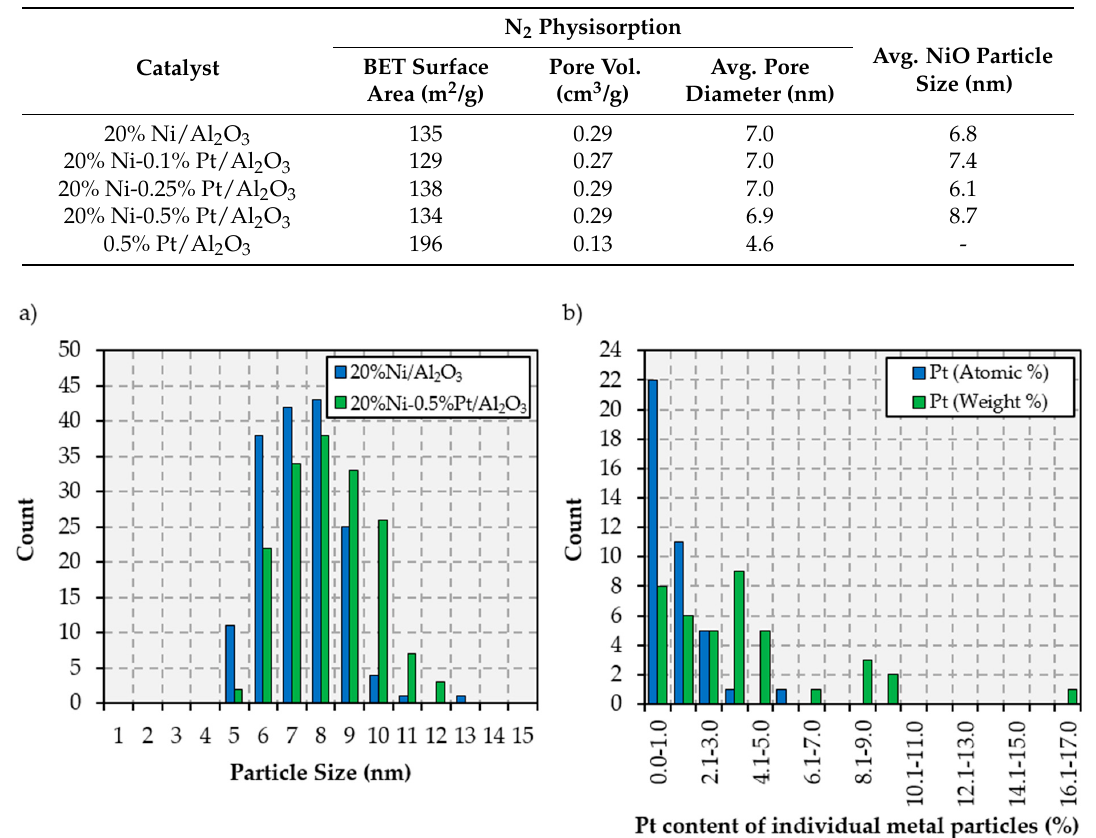
Figure 2. Particle size histograms for the 20% Ni-/Al 2 O 3 and 20% Ni-0.5% Pt/Al 2 O 3 catalysts ( a ) and metallic composition histograms for the 20% Ni-0.5% Pt/Al 2 O 3 formulation ( b